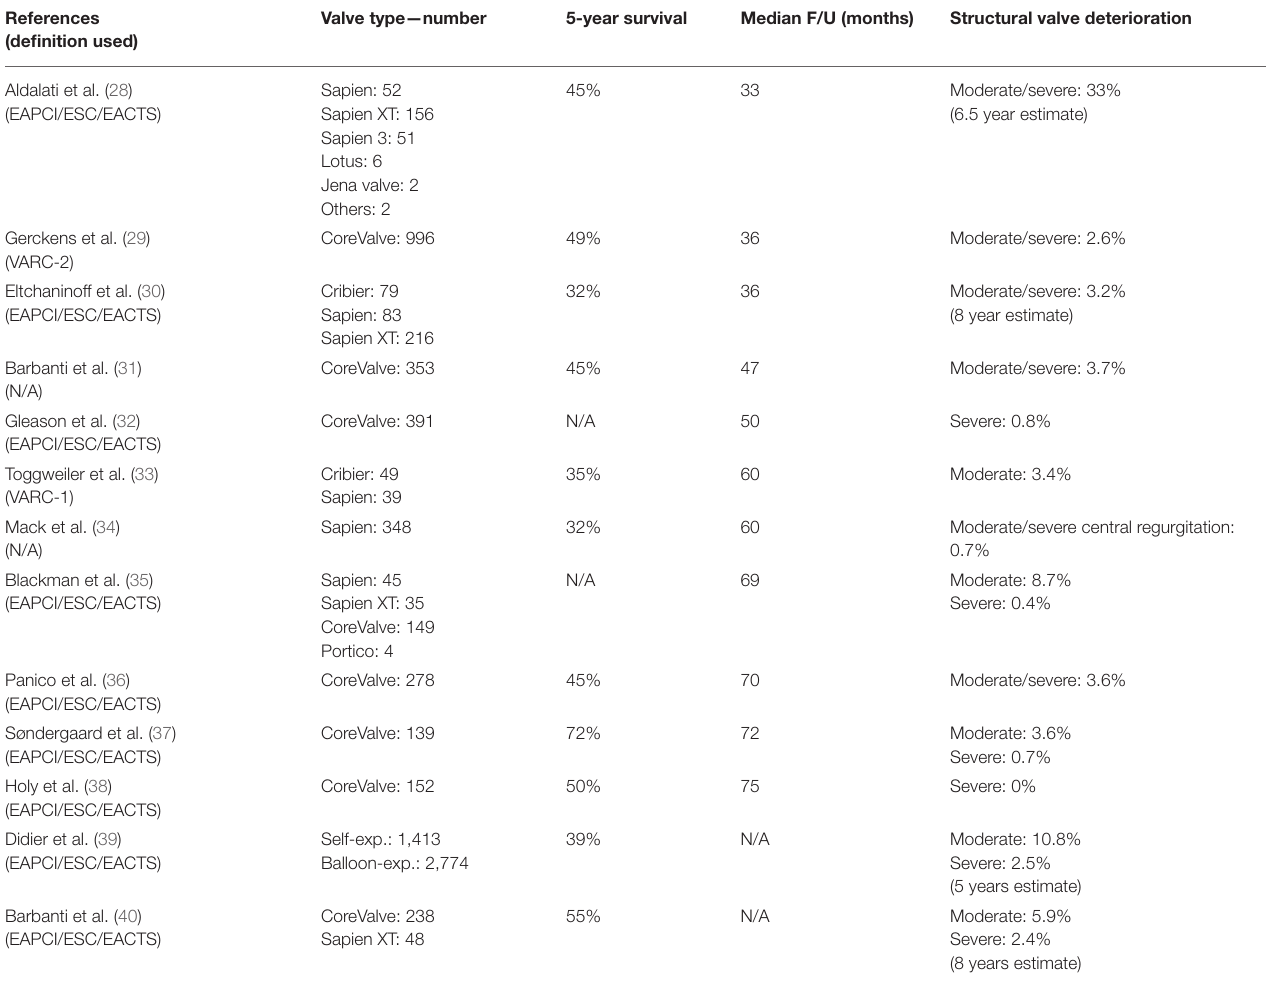
TABLE 2 | Incidence of structural valve deterioration of transcatheter heart